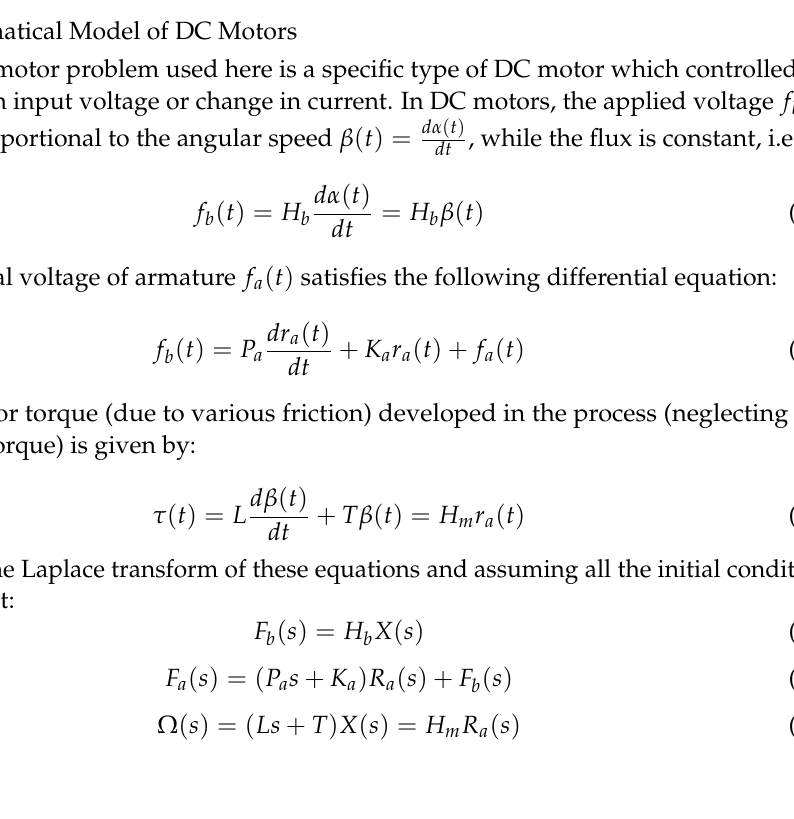
Figure 17. Comparative results of different statistical measures of independent